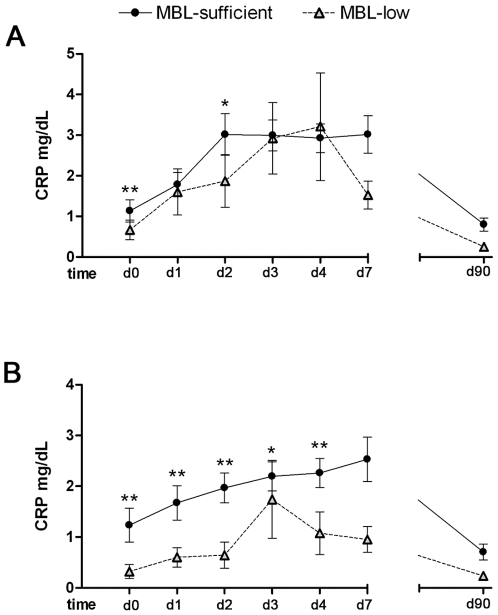
C-reactive protein levels (mg/dL) in MBL-low genotypes and MBL-sufficient genotypes.A) All patients, day 0 (d0) baseline (n = 127; MBL-low = 23, MBL-sufficient = 104); day 1 (d1) (n = 131; MBL-low = 24, MBL-sufficient = 107); day 2 (d2) (n = 132; MBL-low = 24, MBL-sufficient = 108); day 3 (d3) (n = 127; MBL-low = 24, MBL-sufficient = 103); day 4 (d4) (n = 122; MBL-low = 22, MBL-sufficient = 100), day 7 (d7) (n = 111; MBL-low = 19, MBL-sufficient = 92), and day 90 (d90) (n = 68; MBL-low = 12, MBL-sufficient = 56). B) Patients without post-stroke infections, d0 (n = 103; MBL-low = 18, MBL-sufficient = 85); d1 (n = 107; MBL-low = 19, MBL-sufficient = 88); d2 (n = 108; MBL-low = 19, MBL-sufficient = 89); d3 (n = 105; MBL-low = 19, MBL-sufficient = 86); d4 (n = 101; MBL-low = 17, MBL-sufficient = 84), d7 (n = 91; MBL-low = 15, MBL-sufficient = 76), and d90 (n = 60; MBL-low = 11, MBL-sufficient = 49). Values were obtained from serum and are expressed as the mean ± SD. * p<0.05, ** p = 0.01. *p<0.05, **p = 0.01.